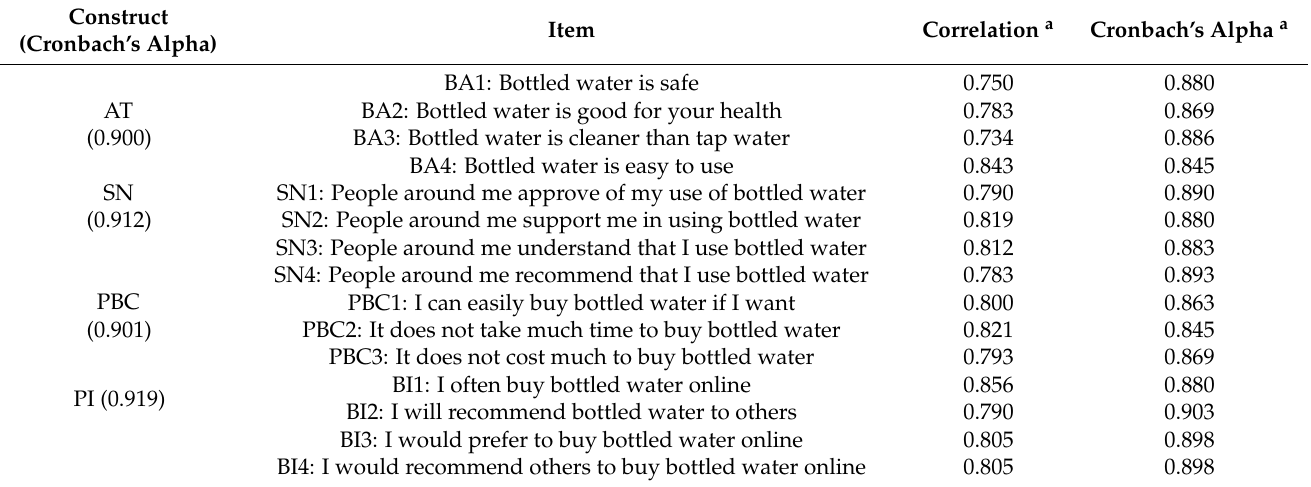
Table A2. Reliability test of the pre-survey planned behavior